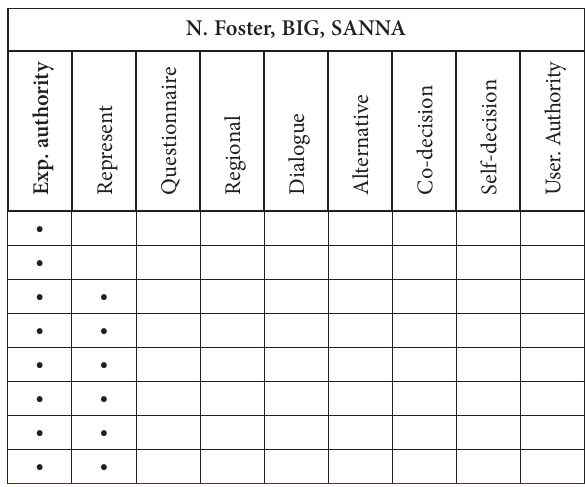
Table 2. Levels of design participation – works of Uhl, Hackney & Alexander (source: Wulz, 1986, p. 161 – Redraw: authors)